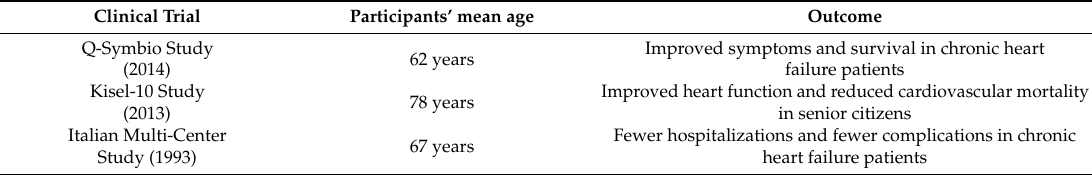
Table 1. Clinical studies conducted with CoQ 10 in the form of ubiquinone in individuals well over the age of 40